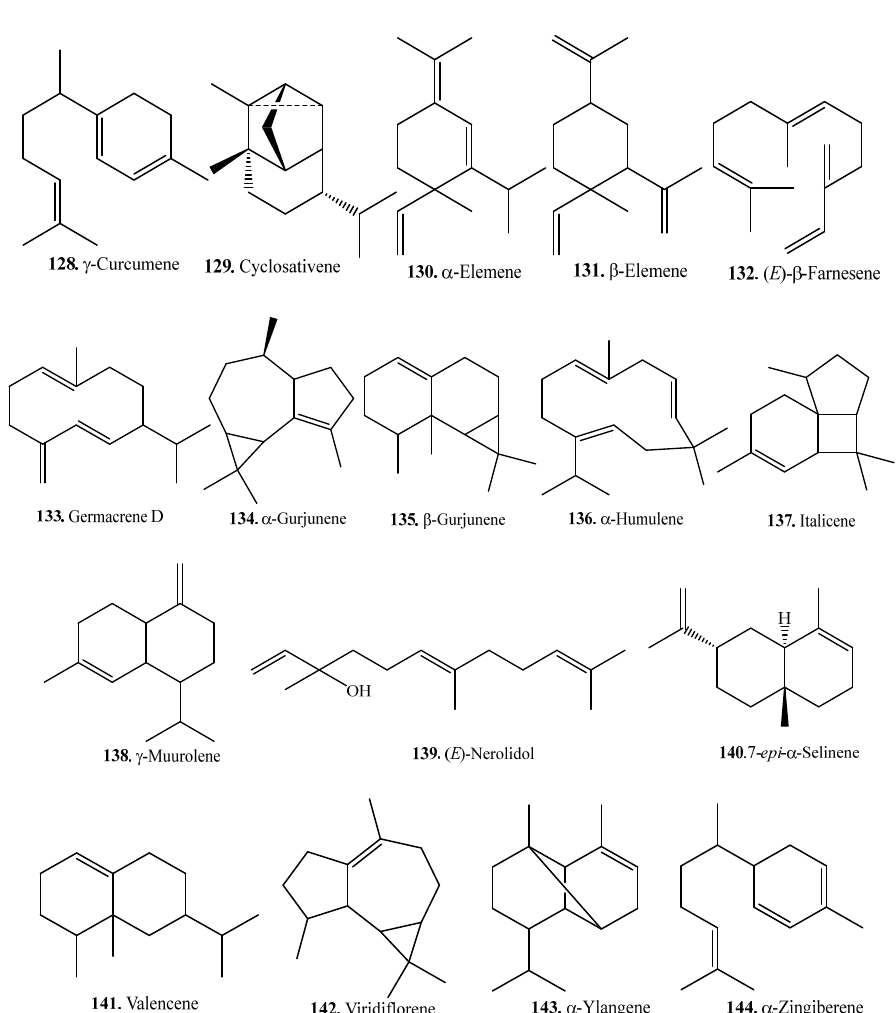
Figure 4. Structures of the sesquiterpenoids isolated from rice.